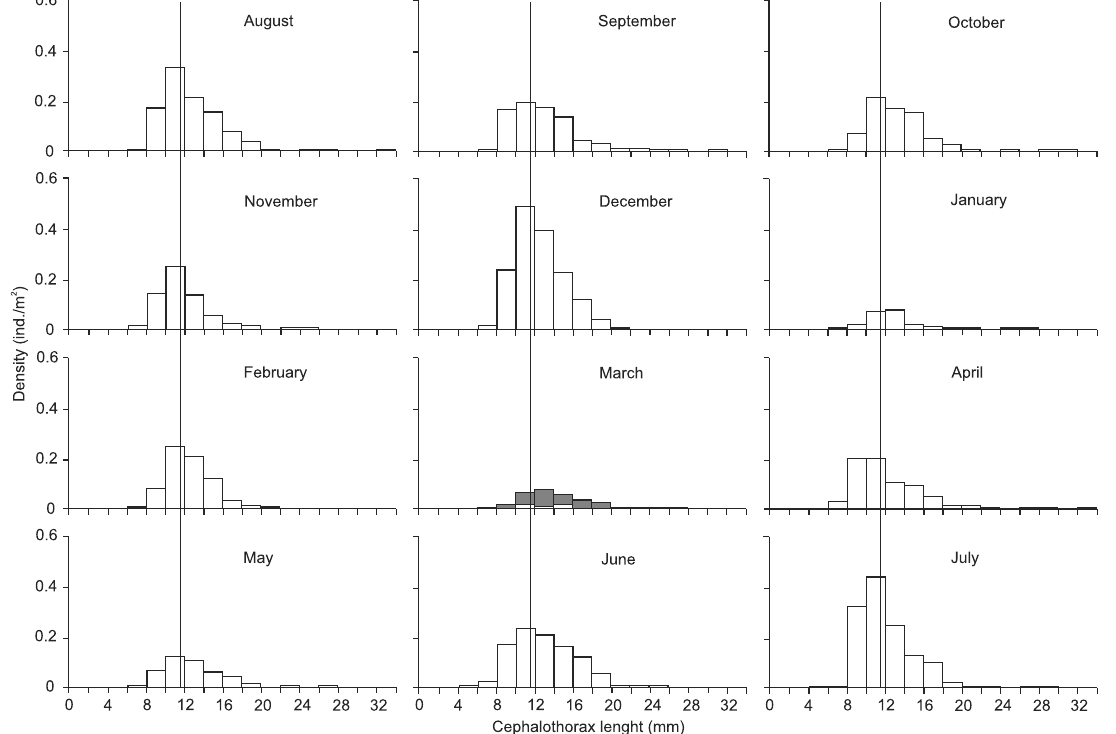
Figure 4. Density by cephalothorax length of M. amazonicum . ( (cid:133) ) Arapiranga Island, ( (cid:132) ) Mosqueiro Island, Amazon estuary of Pará. The dashed lines represent CL . 50